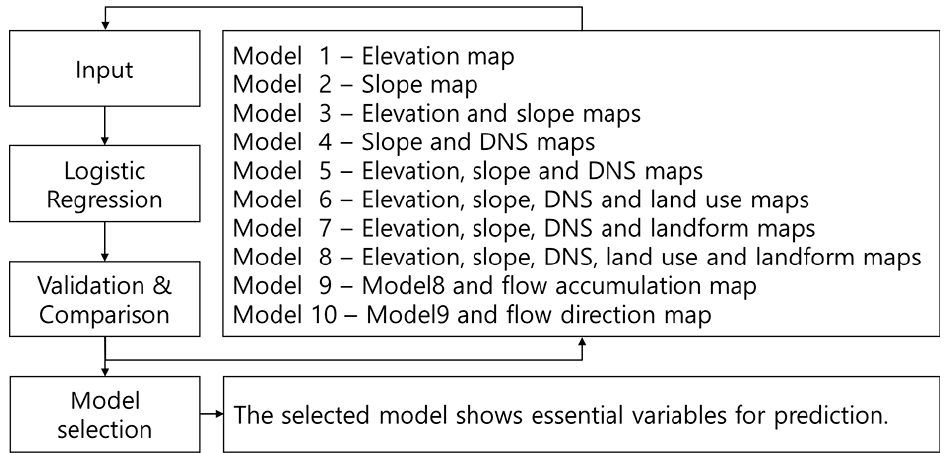
Figure 5. Algorithmic flow diagram of logistic regression.